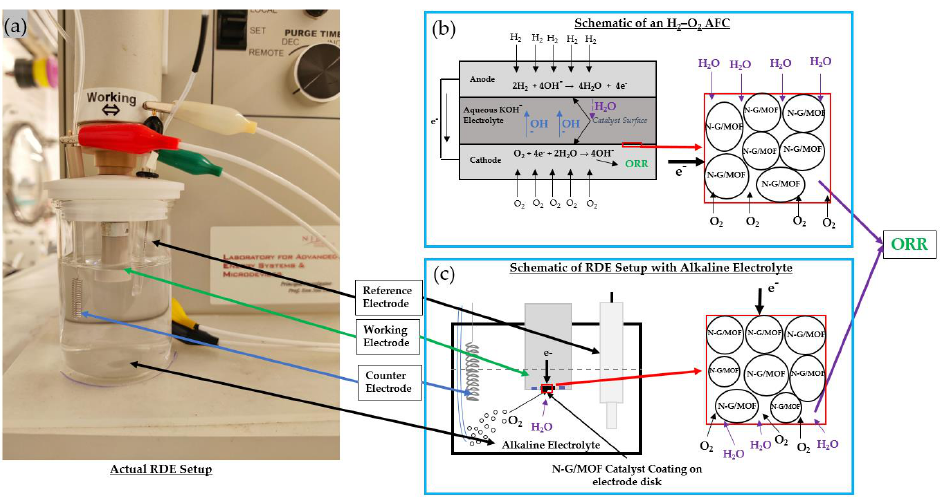
Figure 8. Creating the alkaline medium ORR environment on the AFC cathode within an RDE setup: ( a ) actual test vial of our RDE setup; ( b ) schematic of working process of the H 2 -O 2 AFC; and ( c ) Schematic of the test vial of RDE setup.